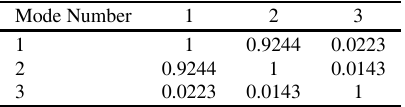
Table 3 MAC values for the periodic chirp measurements